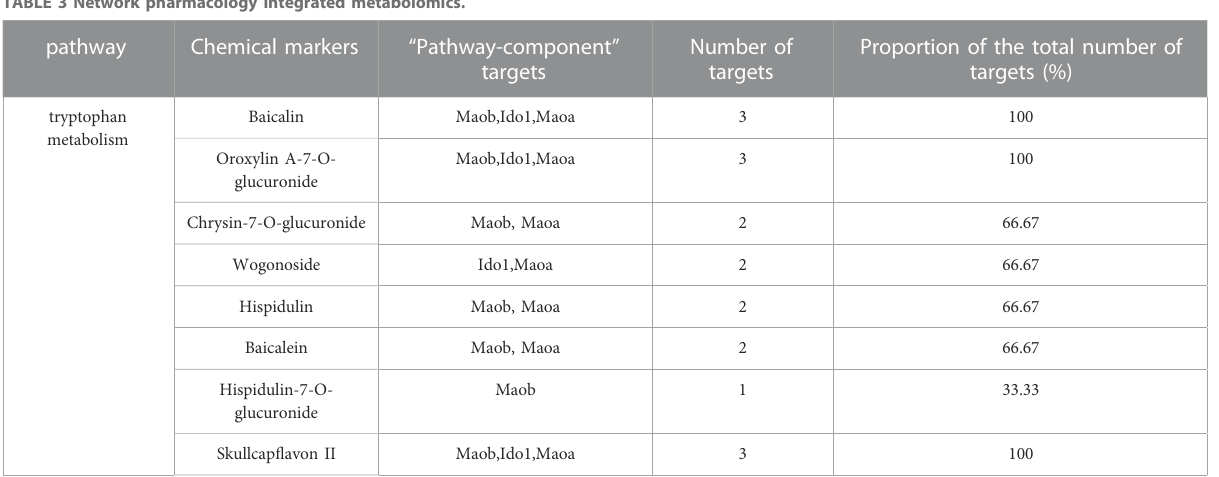
TABLE 3 Network pharmacology integrated metabolomics.